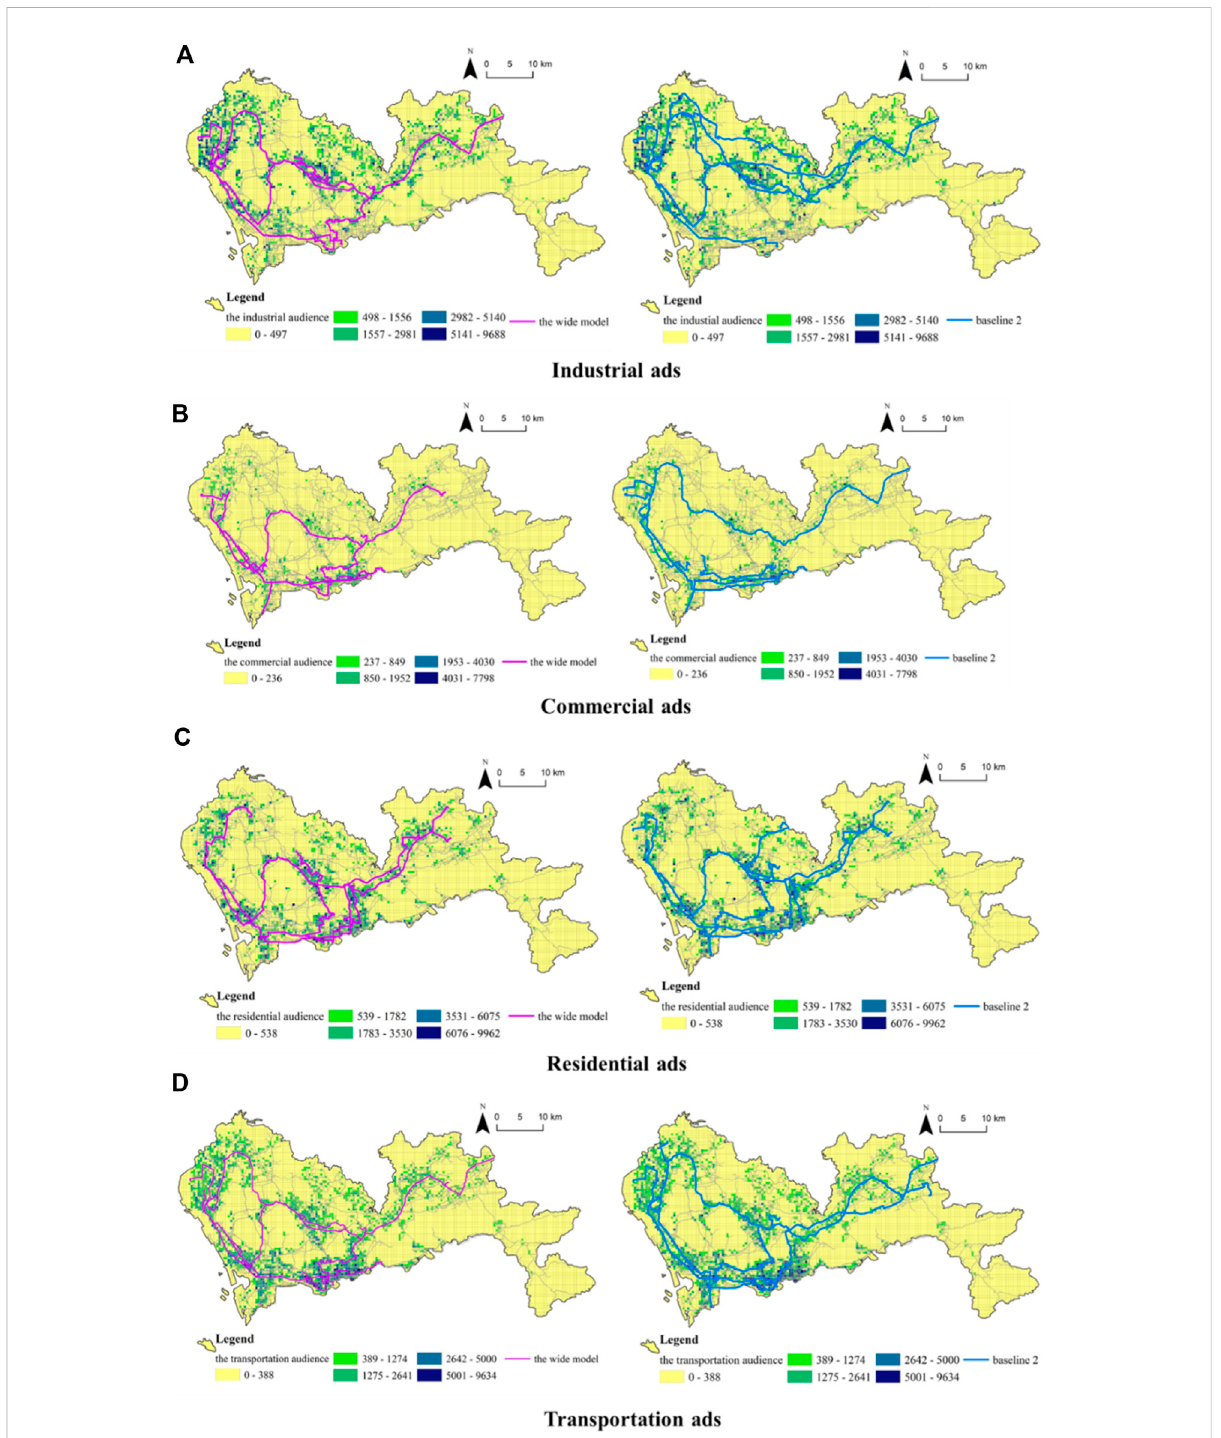
FIGURE 8 The selected bus routes of the wide coverage-oriented model and baseline 2 for (A) Industrial ads, (B) Commercial ads, (C) Residential ads, (D) Transportation